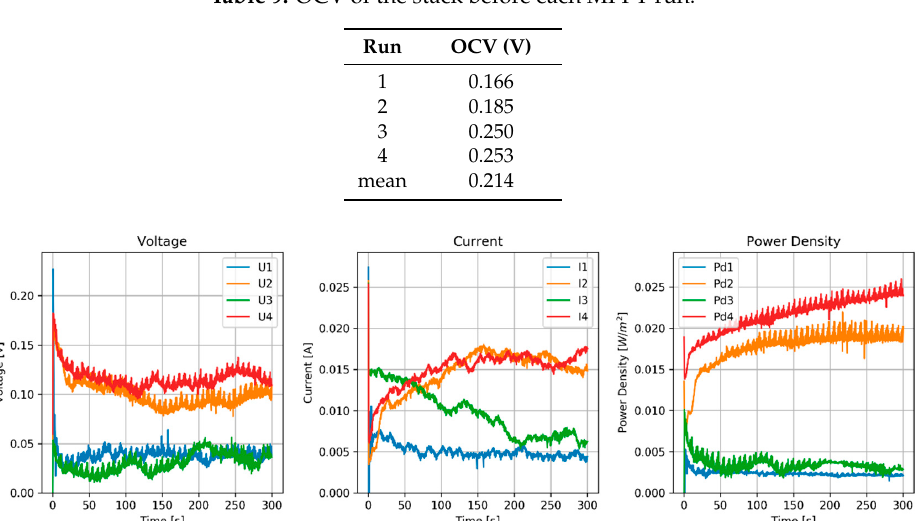
Table 9. OCV of the stack before each MPPT run.